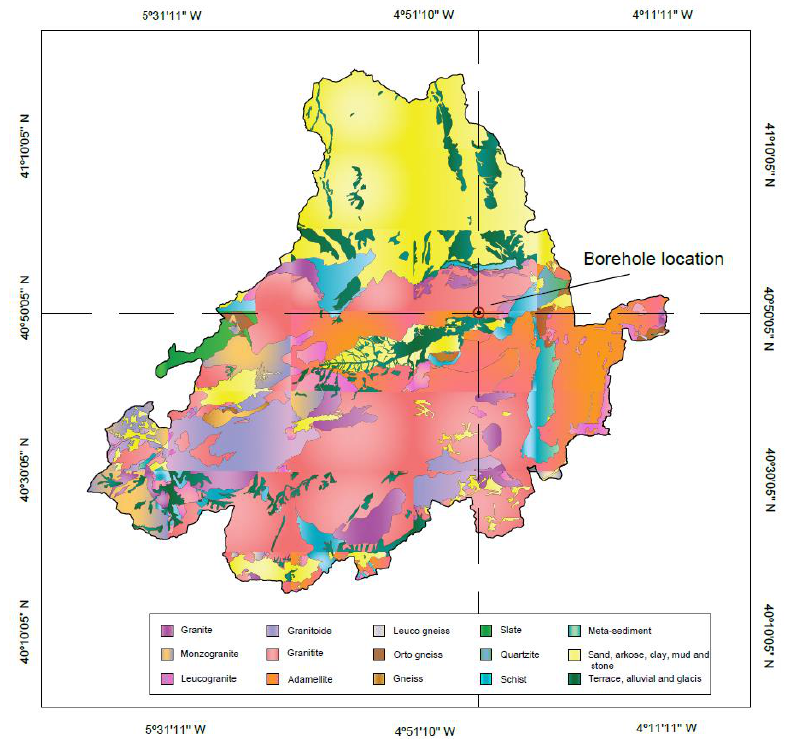
Figure 1. Principal geological formations integrating the region of Á vila [21].